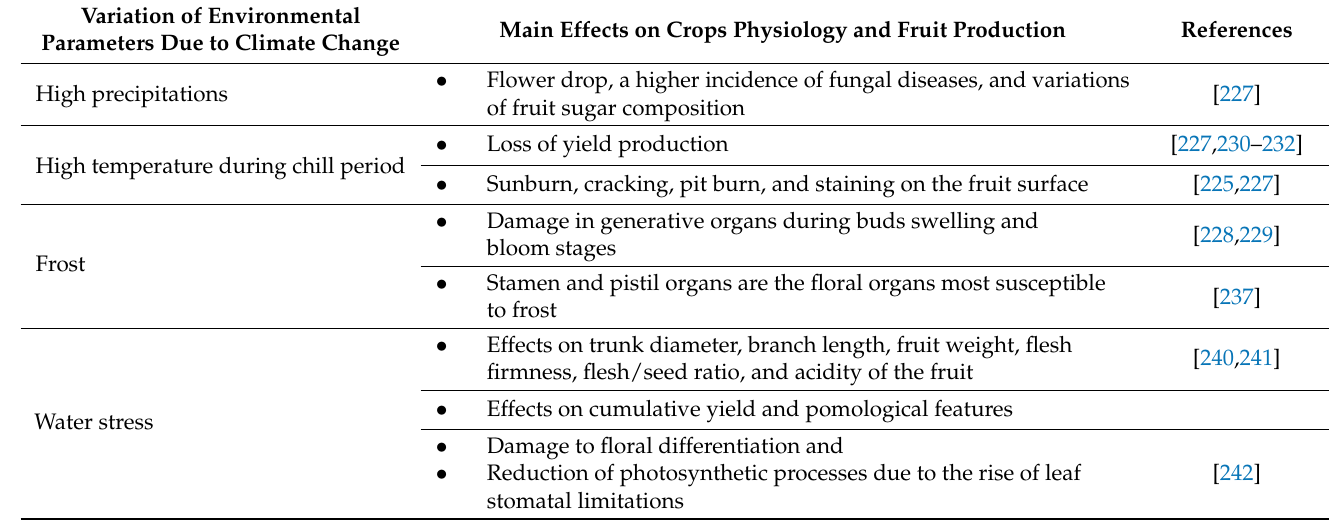
Table 10. Summary of principal effects of environmental conditions variation on apricot species.